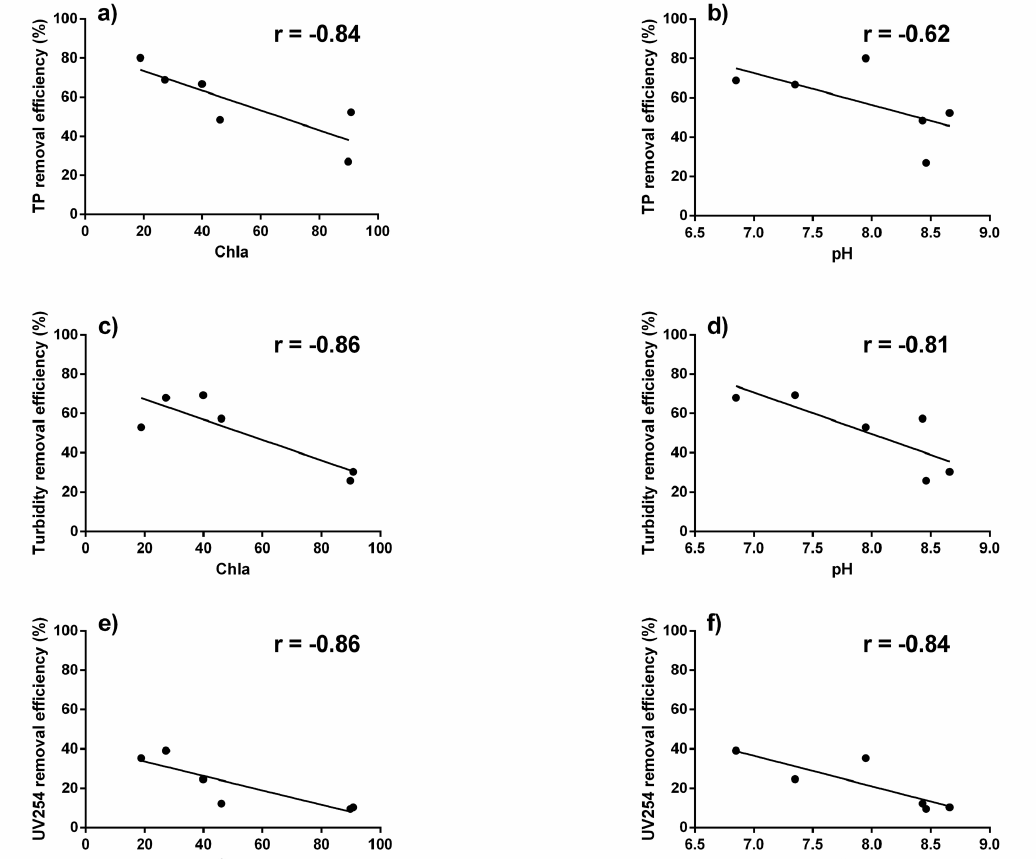
Figure 3. Correlations between chlorophyll- a concentration and pH with total phosphorus (TP), turbidity and UV removal efficiency (%) based on the dose of 4 mg Al L -1